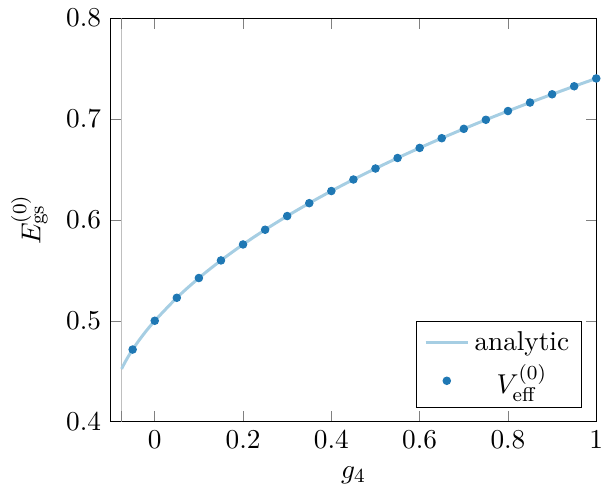
Figure 4. One-matrix E (0) gs versus the quartic coupling g 4